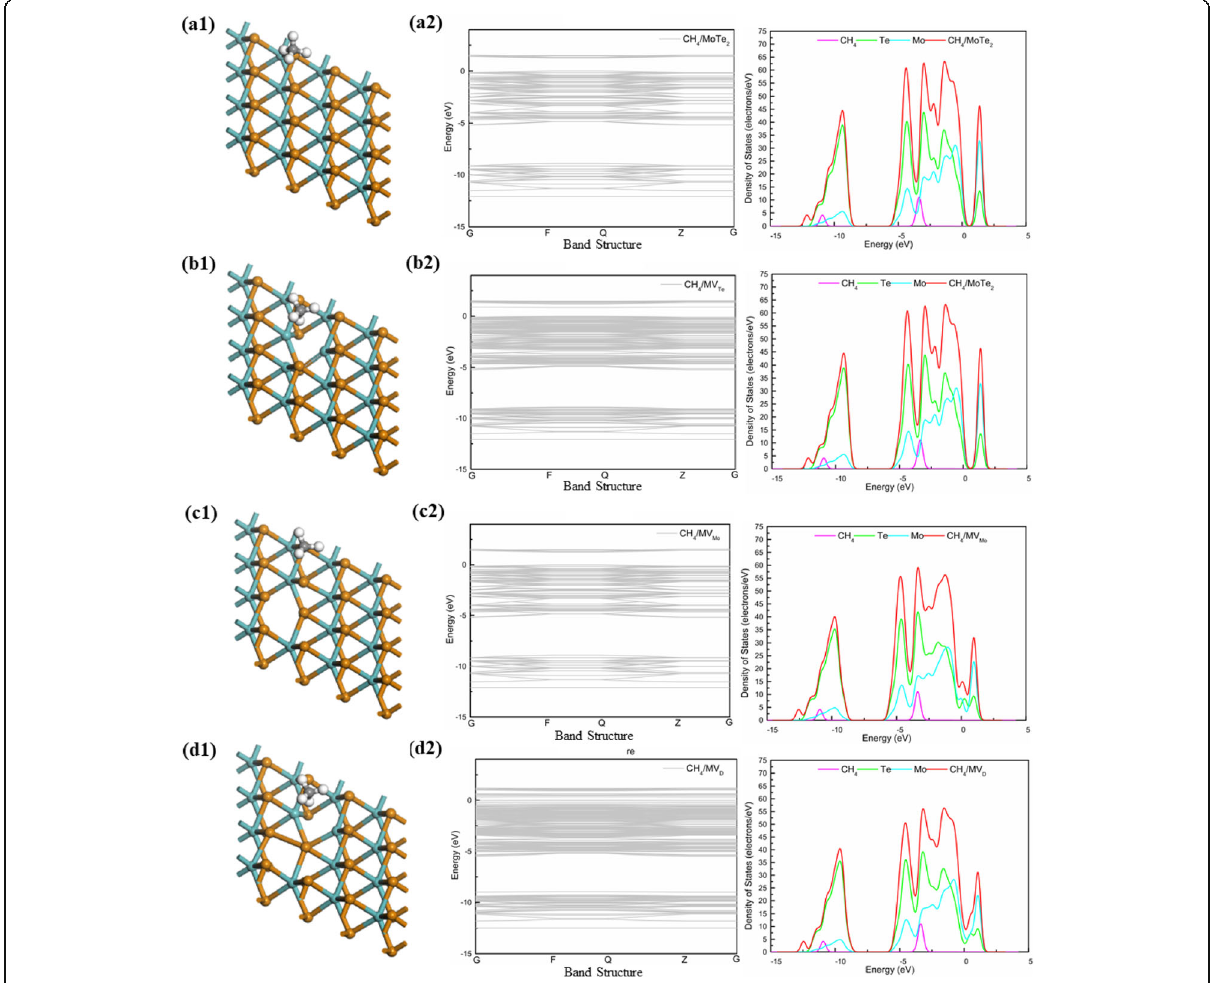
Fig. 6 The structure and DOS of CH 4 gas molecule on four systems (MoTe 2 , MV Te , MV Mo , and MV D